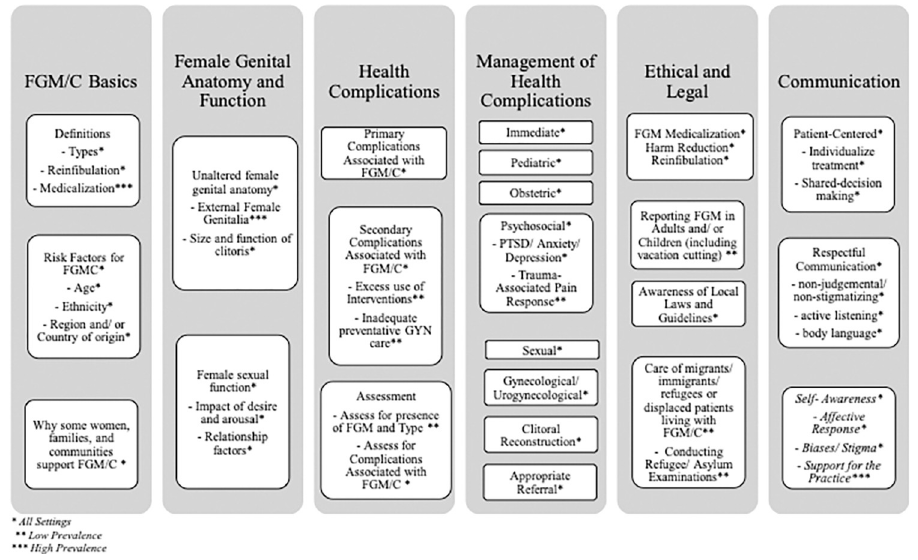
Fig 1. Knowledge: Categories and codes. * All Settings, ** Low Prevalence, *** High Prevalence.